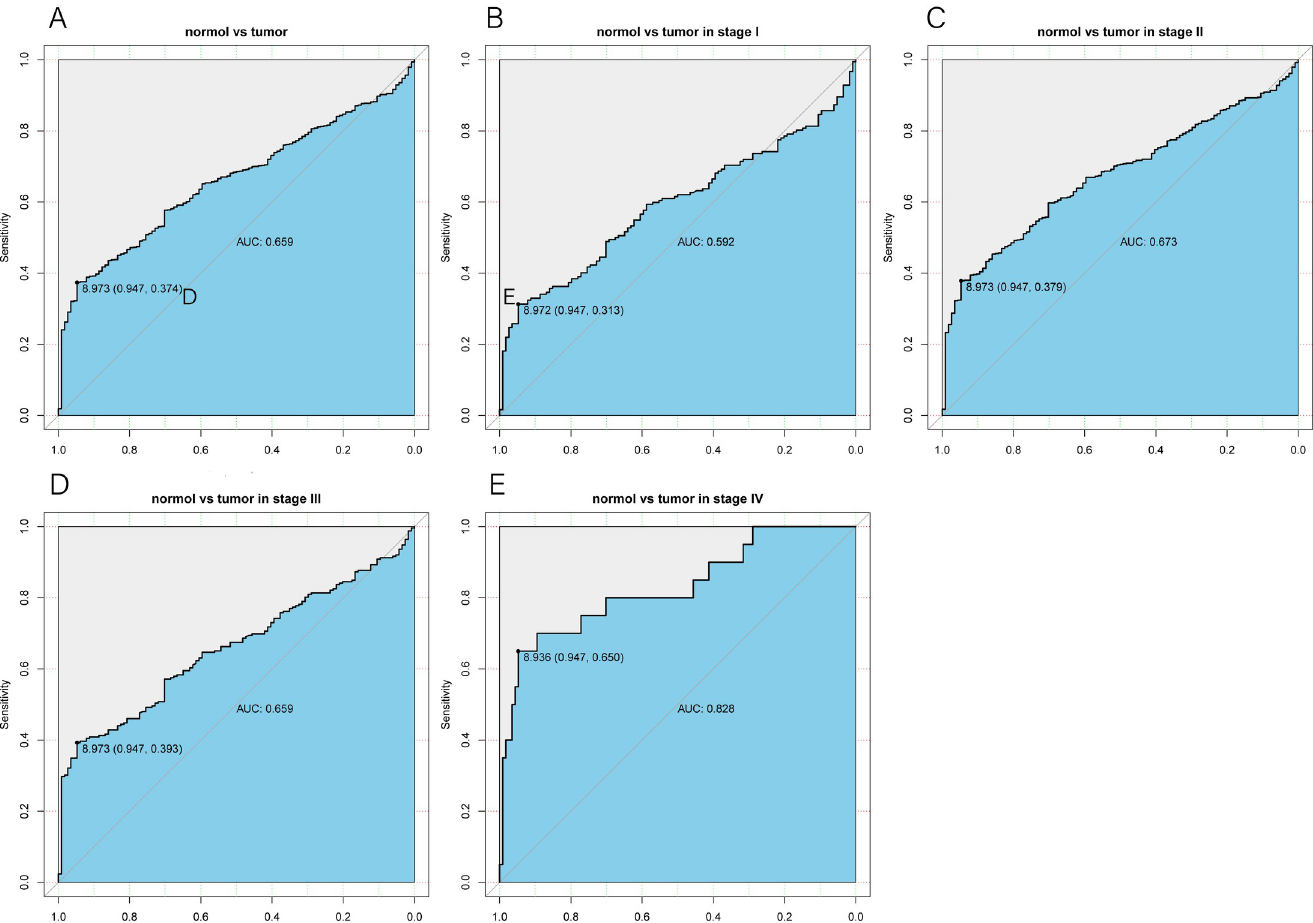
Fig 4. The ROC curve of CCBL2 in breast carcinoma cohort. Normal and tumor samples (A). The AUC (0.659) indicated a limited diagnostic capability. Subgroup analyses: Stage Ⅰ (B) (AUC: 0.592), Stage Ⅱ (C) (AUG:0.673), Stage Ⅲ (D) (AUG:0.659), Stage Ⅳ (E) (AUG:0.828). Abbreviations: AUC, area under the curve; ROC, receiver operating